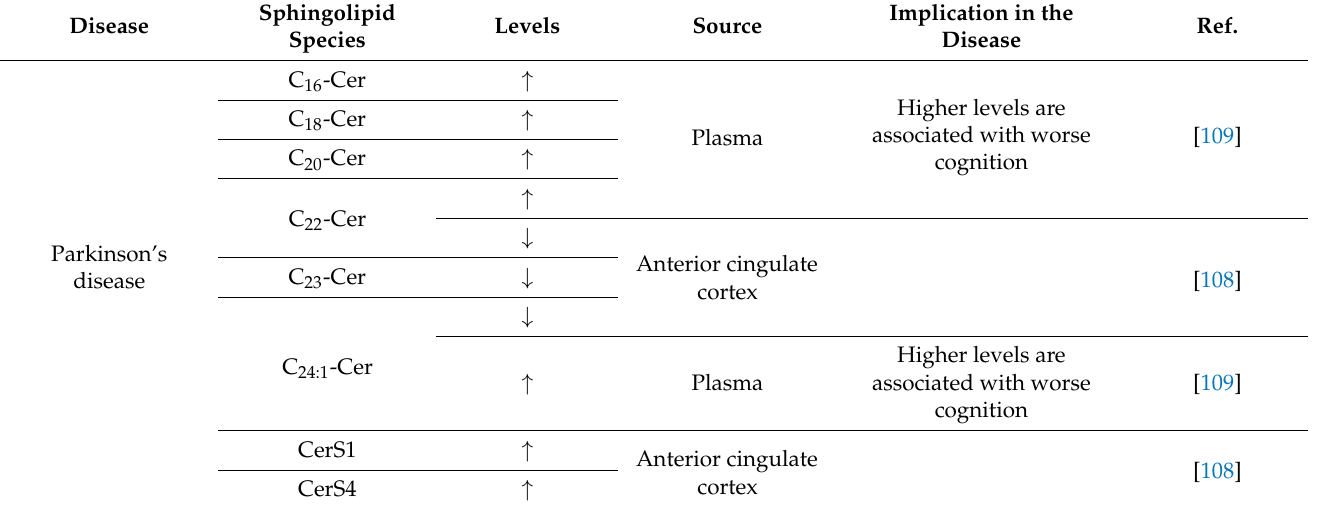
Table 1. Summary table of the implication of sphingolipids in neurodegenerative disease. The upward arrows refer to an increase in levels compared to the controls, while the downward arrows refer to a reduction. Acid ceramidase (ASAH1), acid sphingomyelinase (aSMase), ceramide